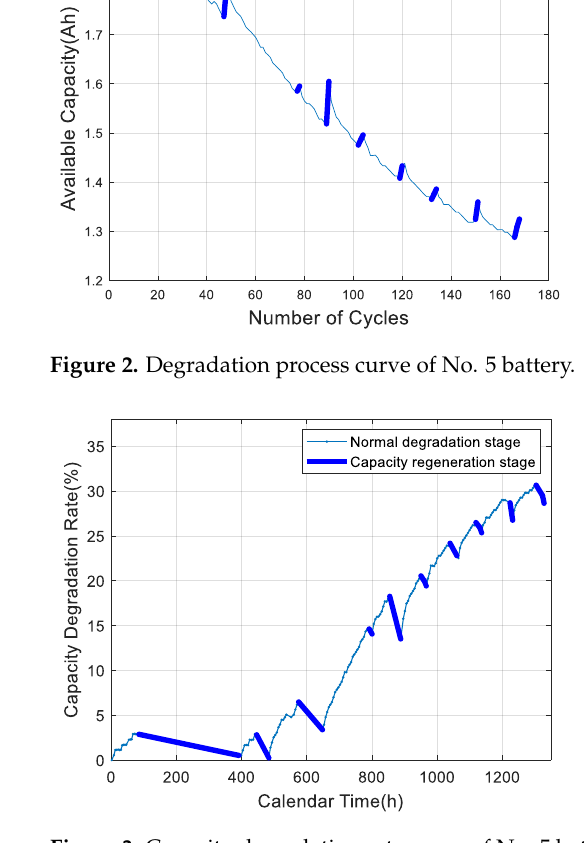
Figure 3. Capacity degradation rate curve of No. 5 battery by calendar time.